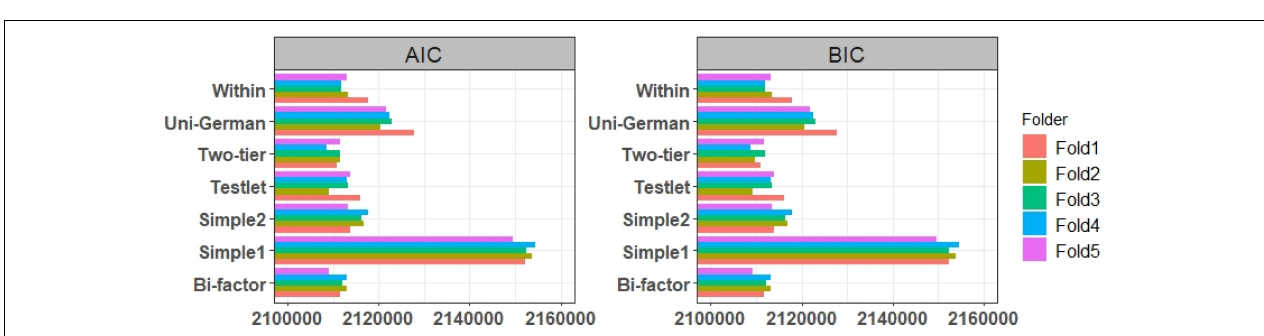
FIGURE 2 | The results of the AIC, BIC values of reading and listening subtests on validation and training sets.